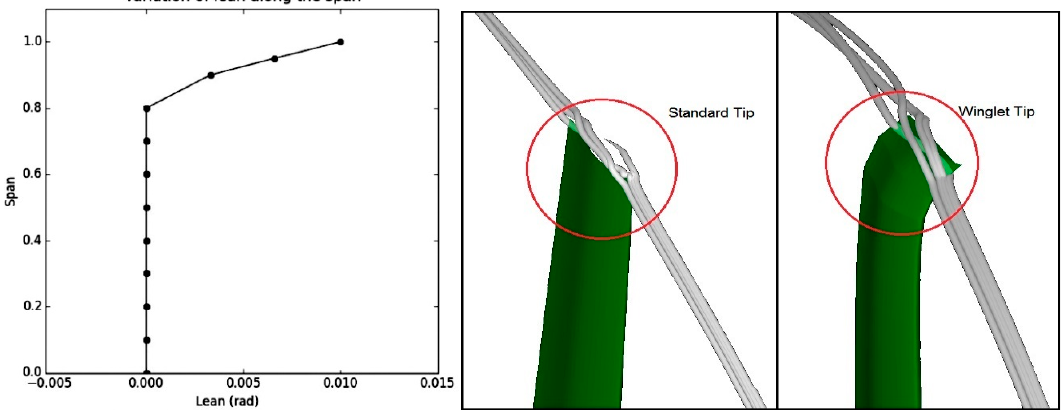
Figure 35. Spanwise local lean defined near the tip with smoother streamlines for winglet blade.